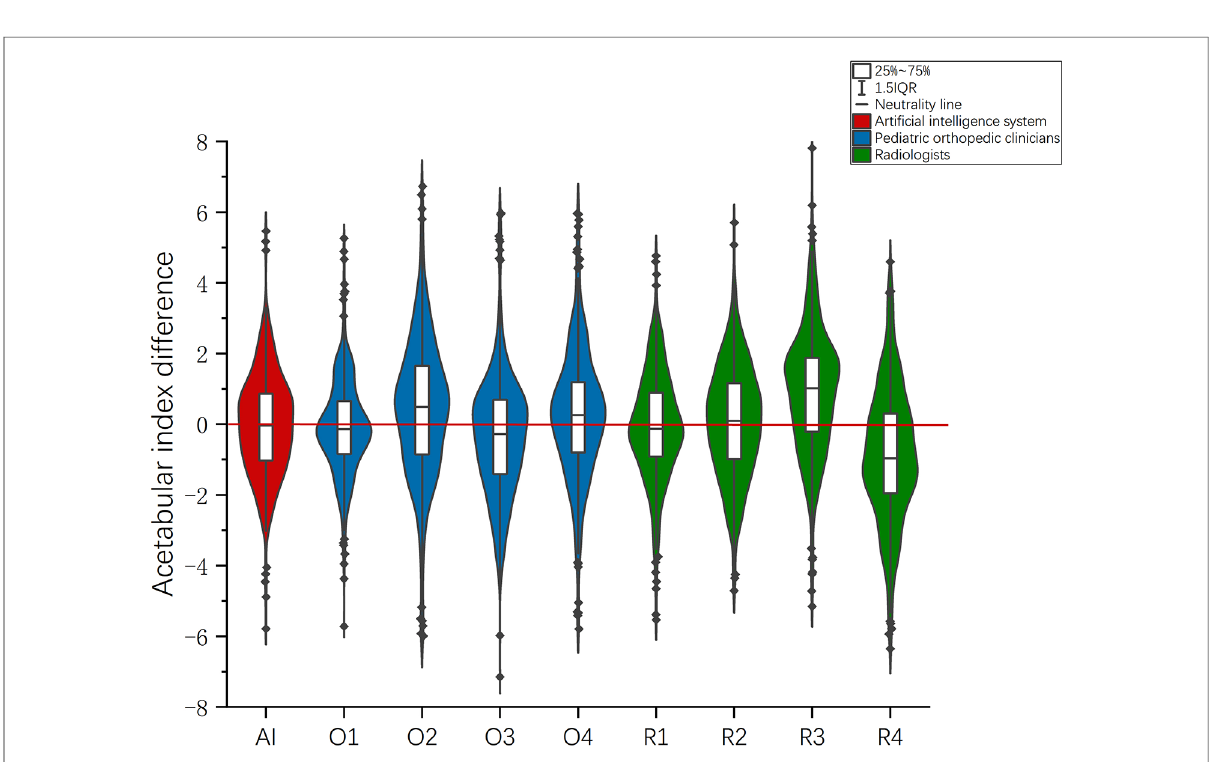
FIGURE 6 In the evaluation of 200 radiographs, the violin chart was drawn according to the difference between the measurement results and those of the expert